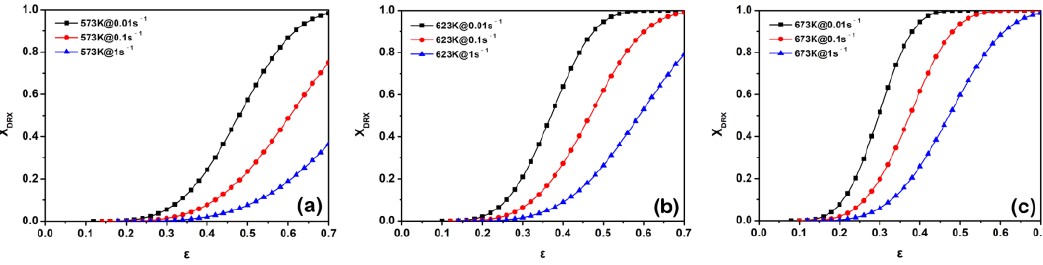
Figure 10. X DRX - ε curves at ( a ) 573 K; ( b ) 623 K; ( c ) 673 K for 0.01, 0.1 and 1 s − 1